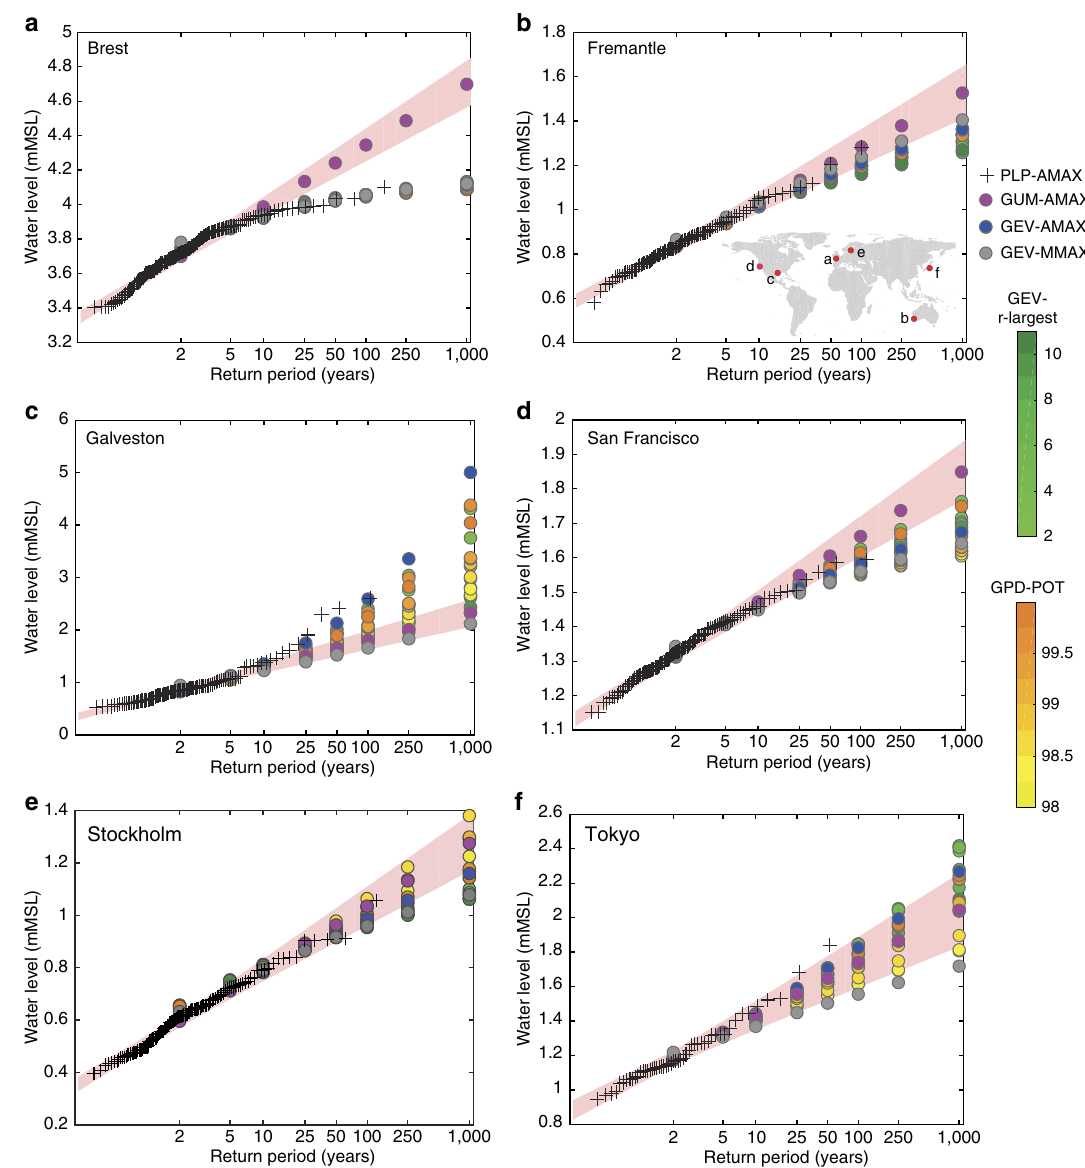
Figure 1 | Spread from using different extreme value analysis methods. ( a – f ) Return water levels are shown for selected tide gauge sites (see panel b for locations). Plotting positions (PLPs) were obtained with the Weibull formula from the observed annual maxima time series (AMAX) and are therefore directly comparable to the Gumbel (GUM) and Generalized Extreme Value (GEV) fits to AMAX but not to results obtained with the Generalized Pareto Distribution (GPD) for varying thresholds and the GEV fits to r-largest time series. Shaded bands are 95% confidence bounds of the GUM-AMAX